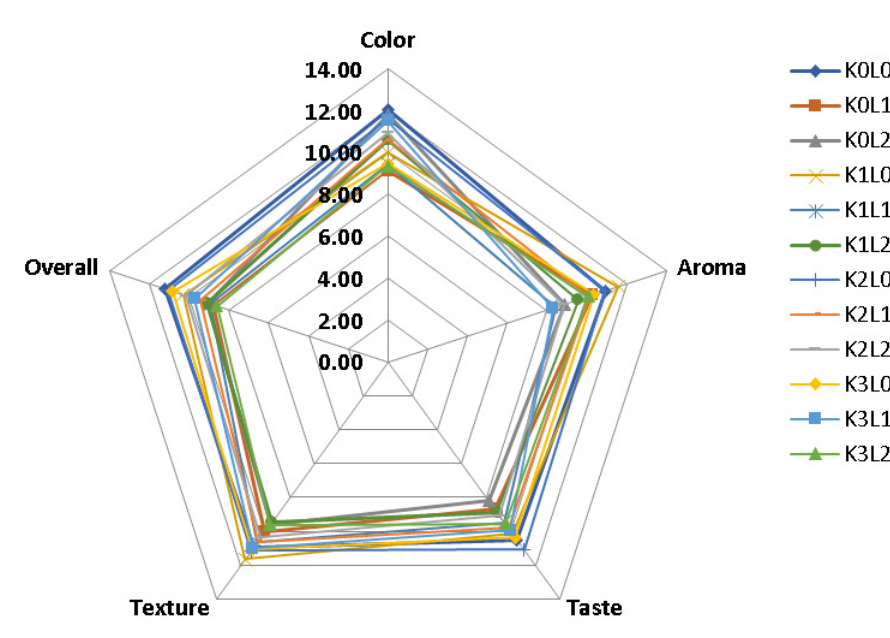
Figure 2. Spider web graph to determine the best treatment of the stink lily noodles.